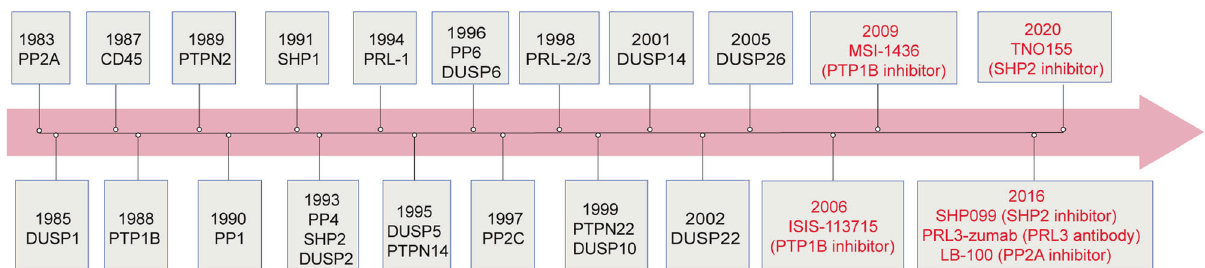
Fig. 2 Timeline of the historical milestone for the discovery of protein phosphatases and their crucial inhibitors. SHP099 and TNO155 are SHP2 allosteric inhibitors. ISIS-113715 and MSI-1436 are PTP1B inhibitors. LB-100 is a PP2A inhibitor. PRL3-zumab is a monoclonal antibody of PRL3. The discovery of all the protein phosphatases take a long time and we show the time point for the fi rst identi fi ed or cloned of all the protein phosphatases involved in the in fl ammation-related diseases (PP2A, 22 DUSP1, 338 CD45, 339 PTP1B, 235 PTPN2, 340 PP1, 23 SHP1, 341 SHP2, 238 DUSP2, 342 PP4, 26 PRL-1, 343 PTPN14, 344 DUSP5, 345 DUSP6, 346 PP6, 27 PP2C, 17 PRL-2/3, 347 PTPN22, 348 DUSP10, 349 DUSP14, 350 DUSP22, 351 and DUSP26 352 ) and the generation and development of their inhibitors in clinical trials (PRL3-zumb, 241 LB-100 242 , ISIS113715, 236 MSI-1436, 237 and TNO155. 240 ) SHP099 is the fi rst allosteric inhibitor of SHP2 found by Novartis in 2016, which is a breakthrough in the study of allosteric inhibitor in the fi eld of designing compound targeting protein phosphatases